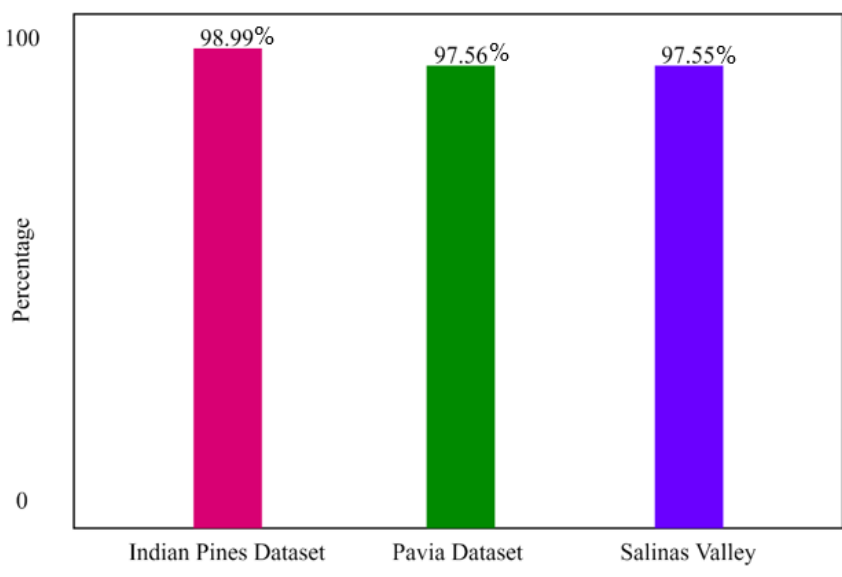
Figure 13. Performance in Each Dataset.